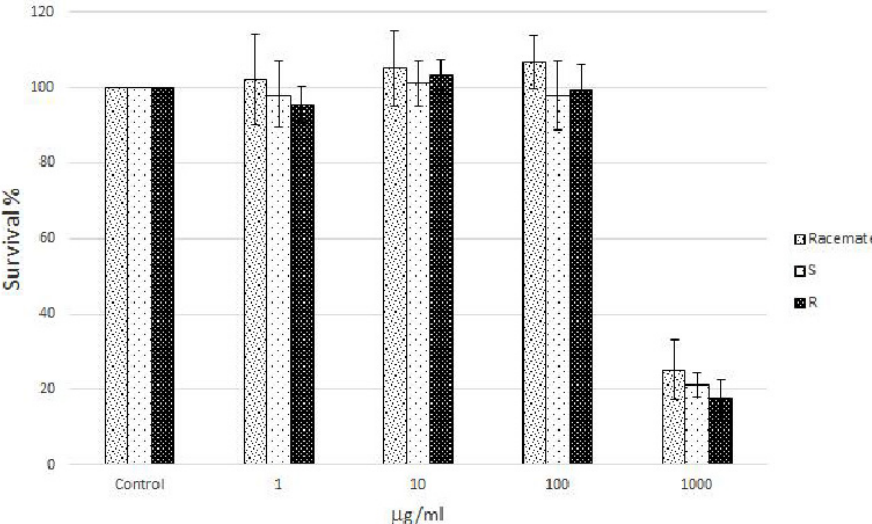
Figure 1. Survival percentage calculated against control (untreated cells) following the treatment of Caco-2 cells with increasing concentrations (1, 10, 100 and 1000 µ g/mL) of racemic naringenin and, ( R ) and ( S ) enantiomers for 24 h. Boxes and error bars represent the mean ± standard deviation over repeat measurements.